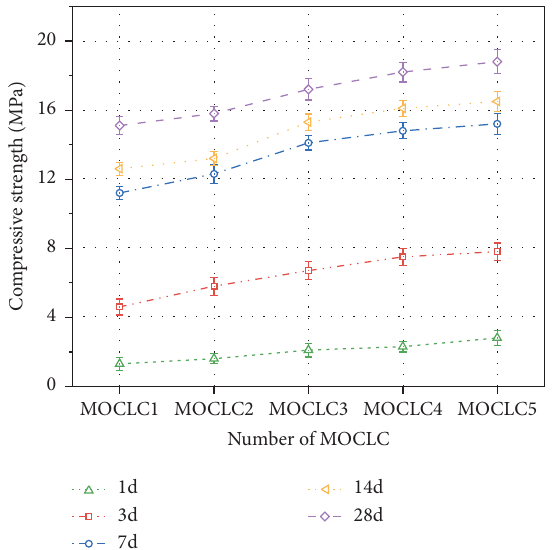
Figure 2: Efect of cement content and age on the compressive strength of